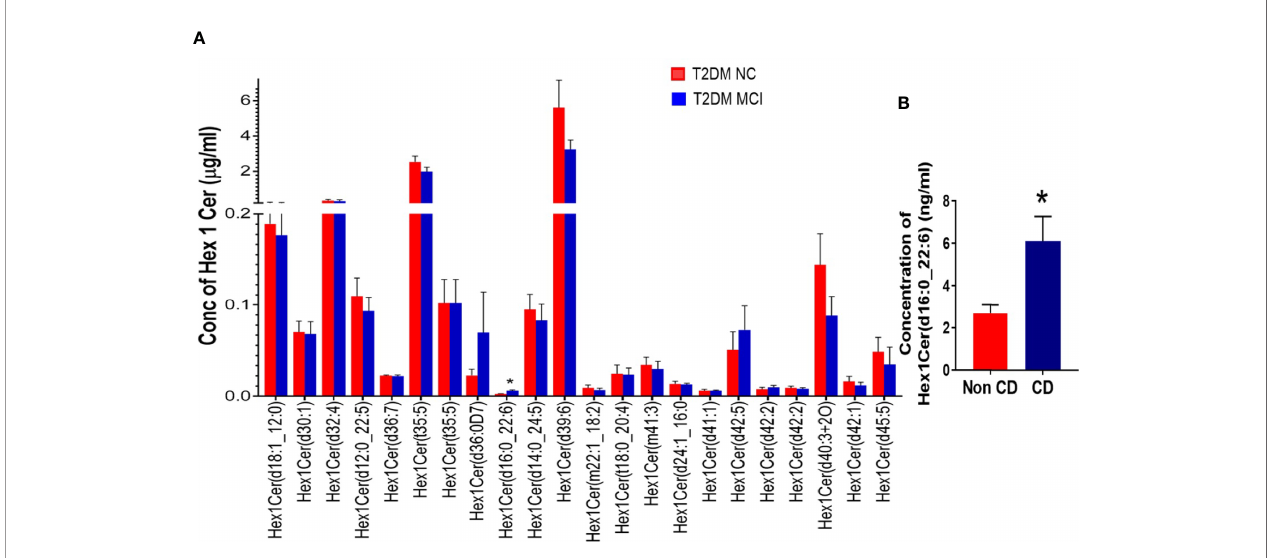
FIGURE 5 | A detailed evaluation of the concentrations of individual species of monohexosylceramides (Hex 1 Cer, 22 species) in patients with MCI compared to the NC group of T2DM patients (A) . This analysis identi fi ed signi fi cantly higher levels of Hex1Cer (d16:0_22:6) in patients with MCI compared to the NC group of T2DM patients [*p < 0.05, (A, B) ]. Although variations were observed among several other Hex1Cer species, no signi fi cant differences were observed between the two